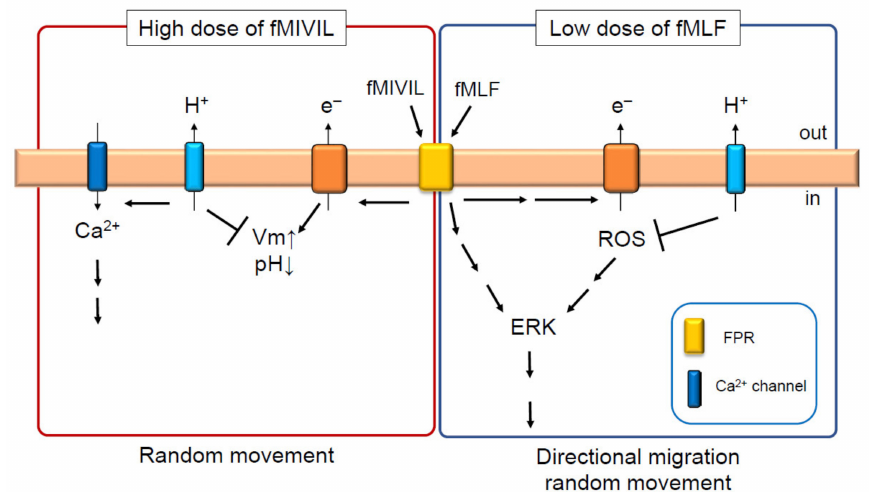
Figure 3. Hv1/VSOP controls the migration of neutrophils by positively and negatively regulating ROS production. In the presence of high dose of fMIVIL, Hv1/VSOP promotes Ca 2+ influx at the plasma membrane by suppressing depolarization induced by NAPDH oxidase [22]. This is necessary for the proper movement of neutrophils in response to fMIVIL [22]. In the presence of low doses of fMLF, Hv1/VSOP inhibits ROS production [25], leading to the suppression of extracellular signal- regulated kinase (ERK) activity and migration of neutrophils in response to fMLF [25]. Arrow and T arrow indicate promotion and inhibition, respectively, for Vm, pH, Ca 2+ , ROS and so